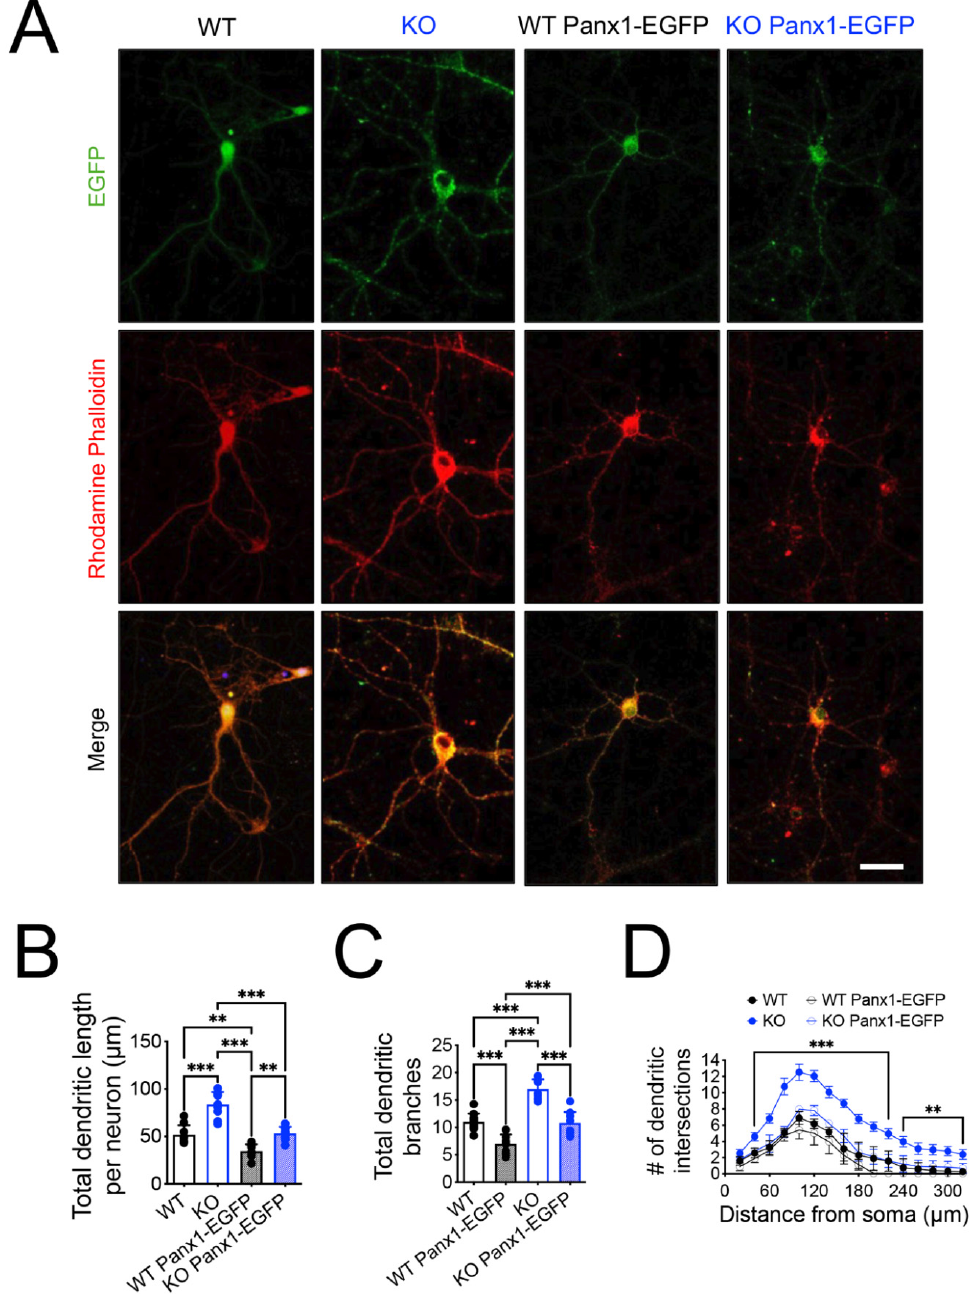
Figure 6. Panx1 regulates morphology in cultured hippocampal neurons. ( A ) Representative images of DIV 14 hippocampal neurons transfected with EGFP or Panx1-EGFP ( green ) and stained with rhodamine-phalloidin ( red ). Magnification, 40X; Scale bar, 15 μ m. n = 10 (WT) and n = 14 (KO) cells from 5–6 cultures. ( B ) Quantification of dendritic length. n = 54 (WT) and n = 55 (KO) cells from 5–6 cultures, ** p = 0.003, *** p < 0.001 two-way ANOVA test. ( C ) Total of the dendritic branch. n = 54 (WT) and n = 55 (KO) cells from 5–6 cultures, *** p < 0.001 two-way ANOVA test. ( D ) Sholl analysis of dendritic arbors. n = 54 (WT) and n = 55 (KO) cells from 5–6 cultures, ** p < 0.005, *** p < 0.001 two- way ANOVA test.